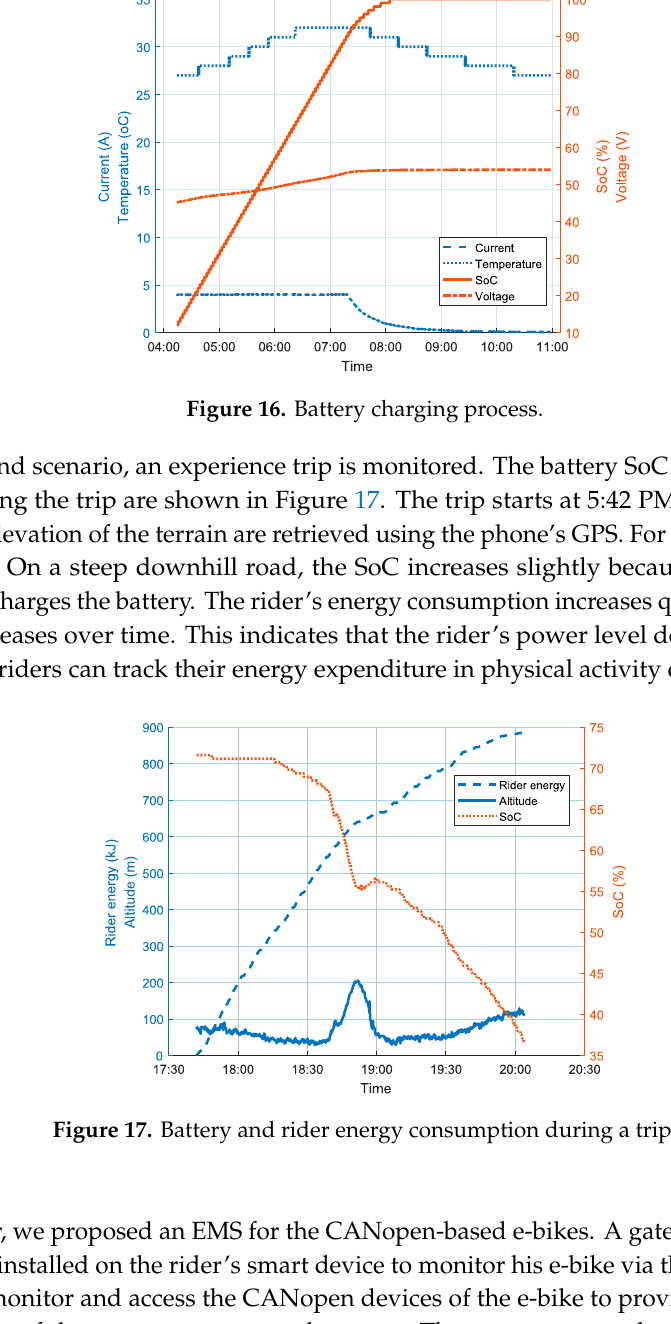
Figure 17. Battery and rider energy consumption during a trip.